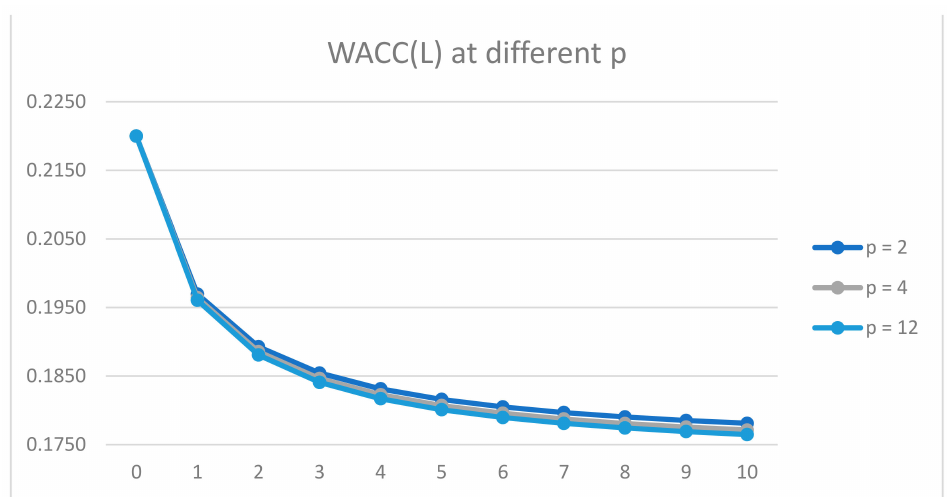
Figure 3. Dependence of the weighted average cost of capital ( WACC ) on leverage level L at different p and fixed k 0 =